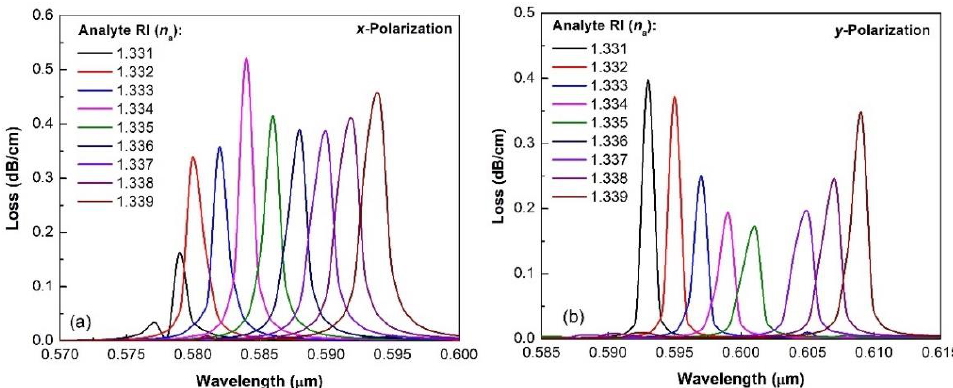
Figure 3. The wavelength-dependent loss spectra for different analyte RI: ( a ) x and ( b ) y polarized modes for graphene layer of thickness of 36.72 nm. Table 2. Summarized numerical results of the proposed